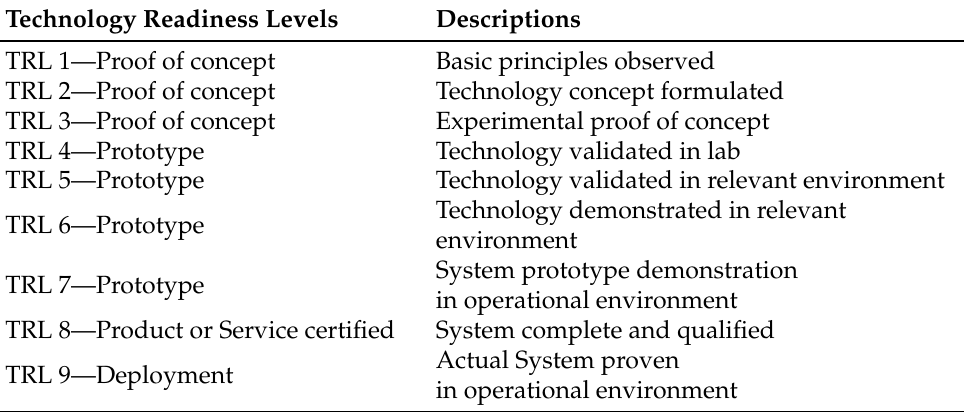
Table 3. Technology Readiness Levels (TLRL).